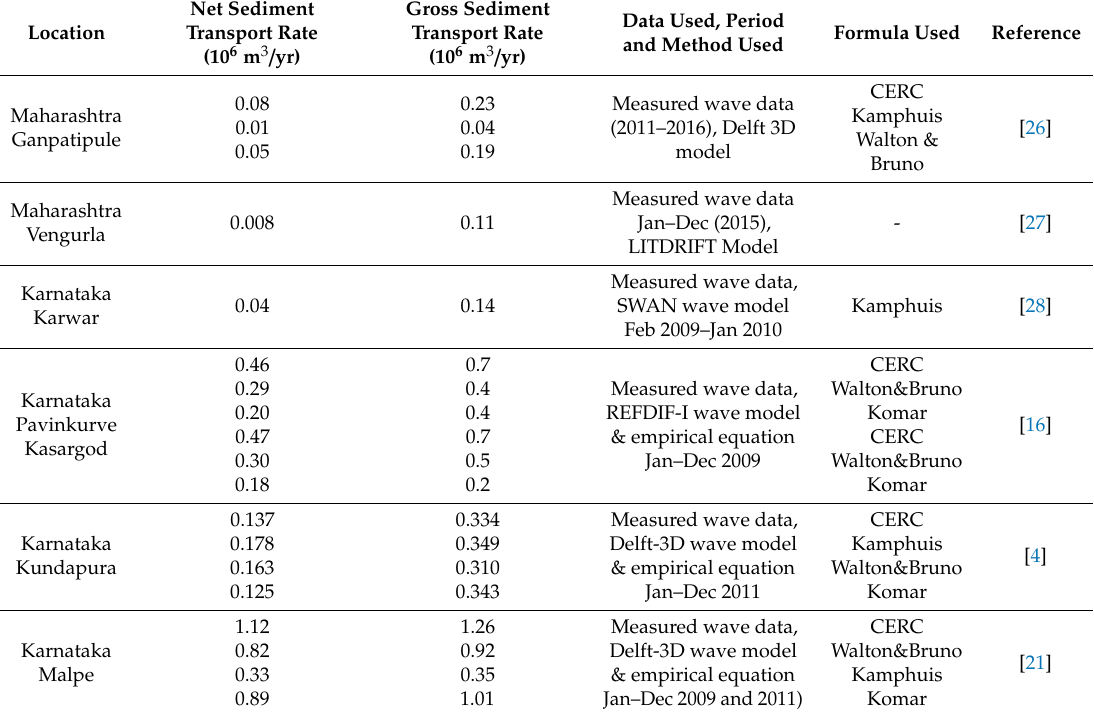
Table 1. Longshore sediment transport rate (LSTR) along the west coast of